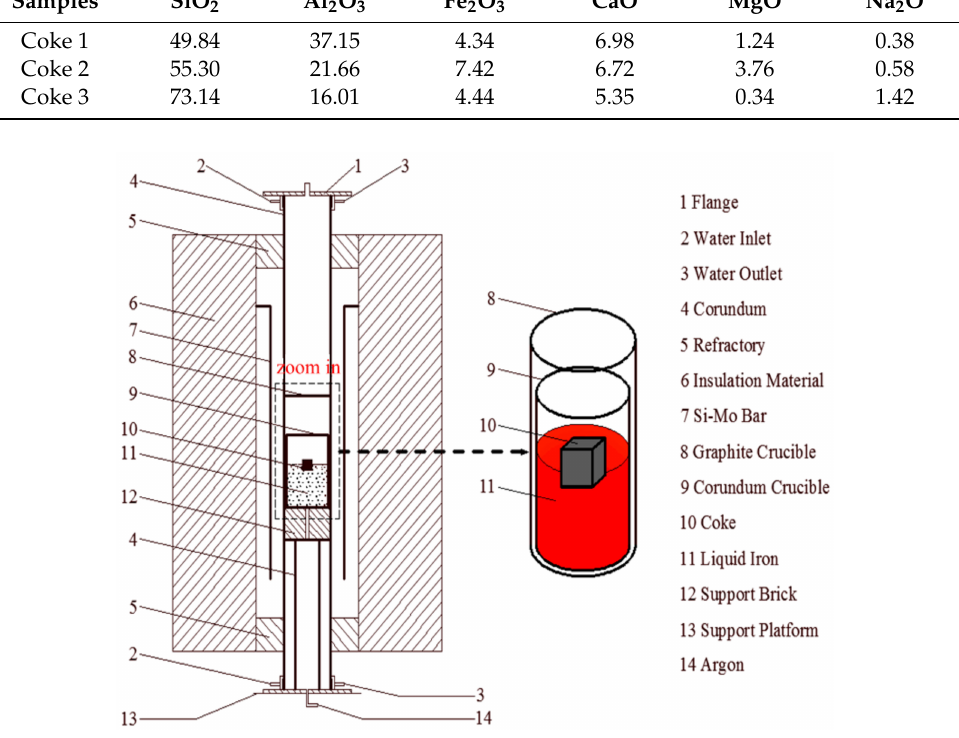
Figure 1. Schematic diagram of the experimental